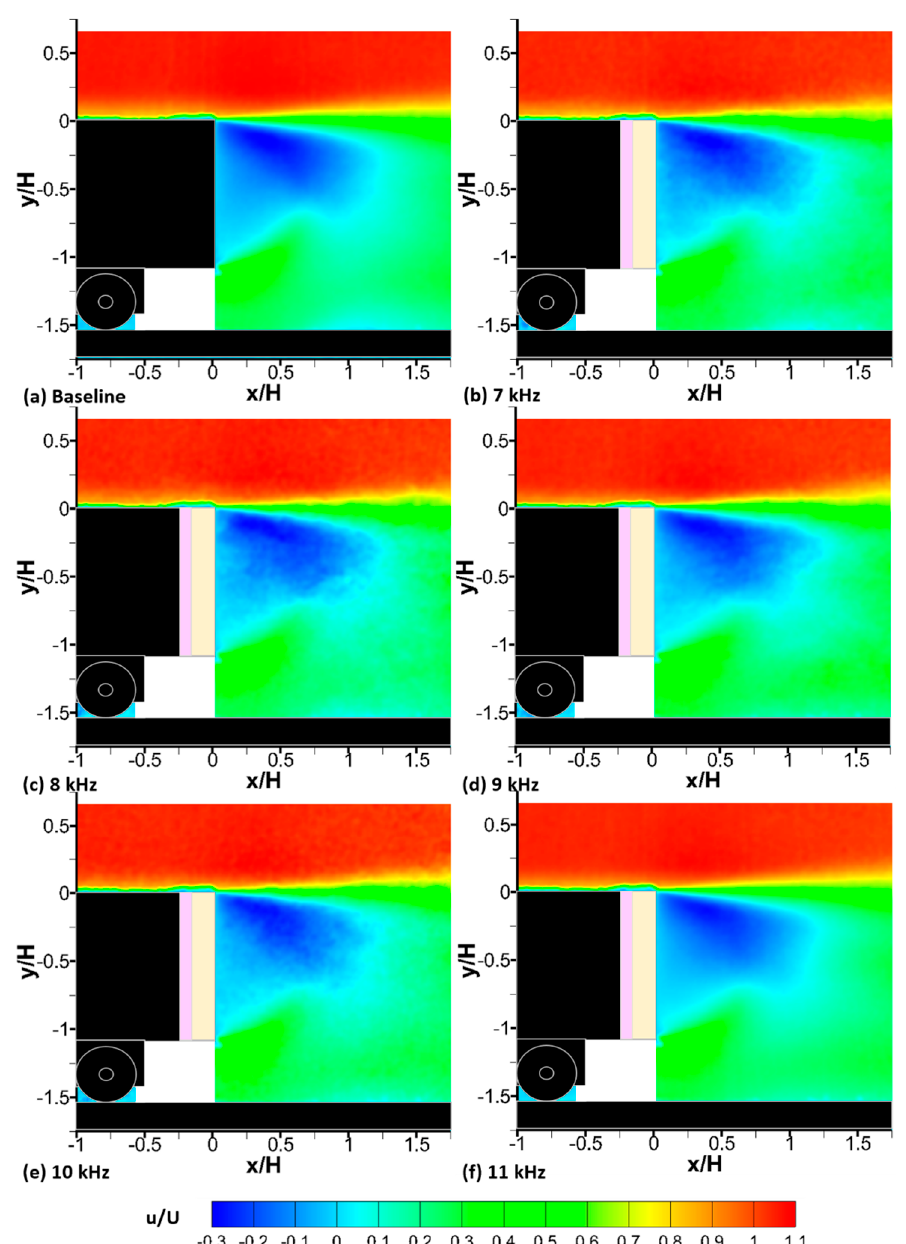
Figure 10. Normalised x-velocity contour downstream of the trailer rear end at various plasma actuation frequencies. ( a ) Baseline, ( b ) 7 kHz, ( c ) 8 kHz, ( d ) 9 kHz, ( e ) 10 kHz, and ( f ) 11 kHz.